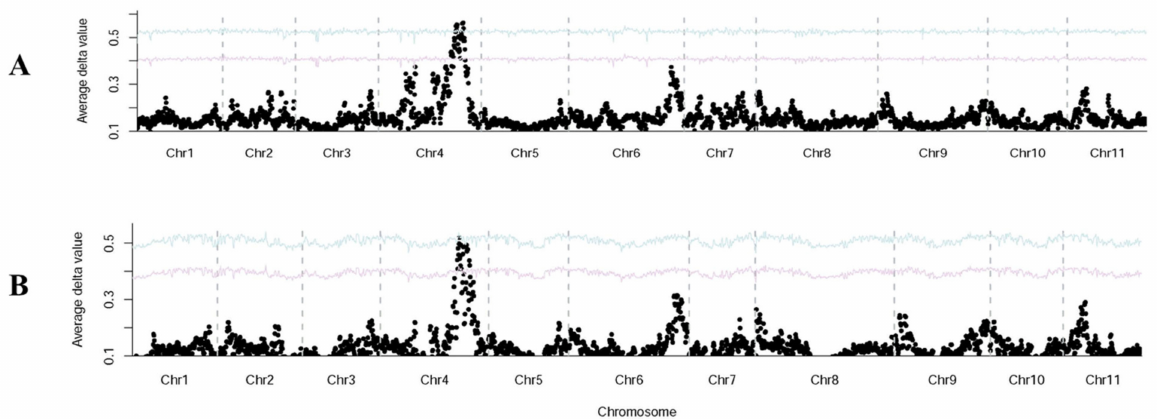
Figure 2. Genomewide ∆ SNP-index plot using SNPs between CR and DCR pools suggests that cr is located on Chr4 (BLBB01000004.1) in long-read genome of OHB3-1 ( A ) and Chr4 (MC04) in genome Dali-11 ( B ). The Confidence intervals were revealed with purple lines ( p < 0.05) and blue lines ( p < 0.01).